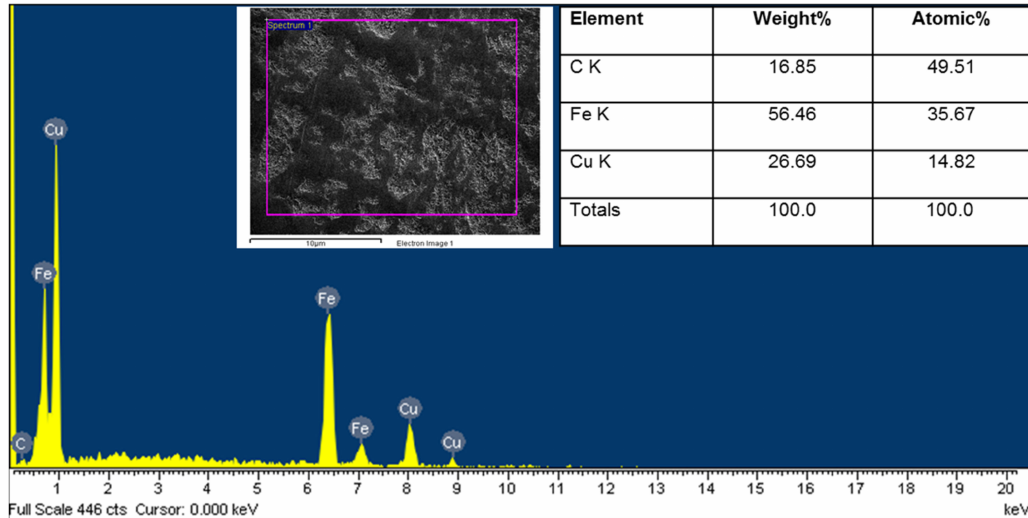
Figure 4. EDS spectrum of the Cu/PANI@AH36-3 (the inset is the elemental composition of a specific